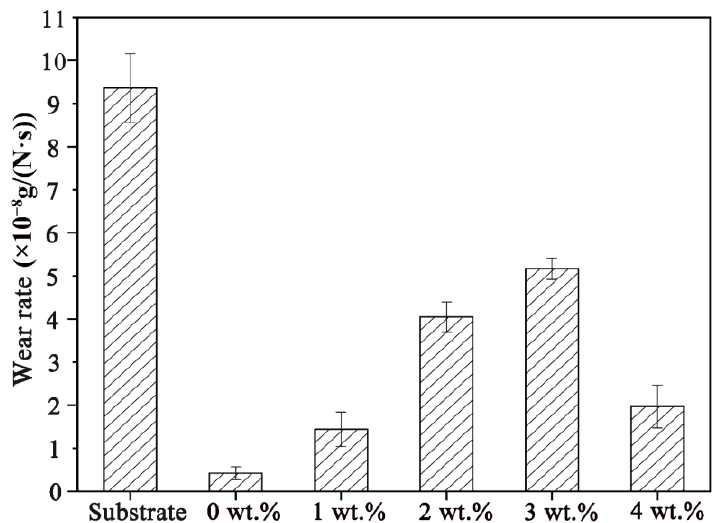
Figure 14. Wear rates of the substrate and composite coatings with various CeO 2 contents.